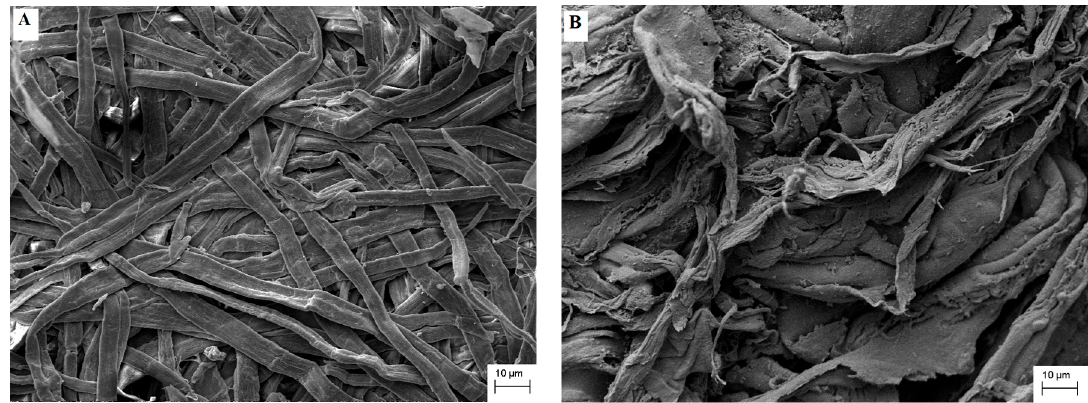
Figure 3. Scanning electron microscopy for samples of ( A ) Kraft pulp and ( B ) CTA.